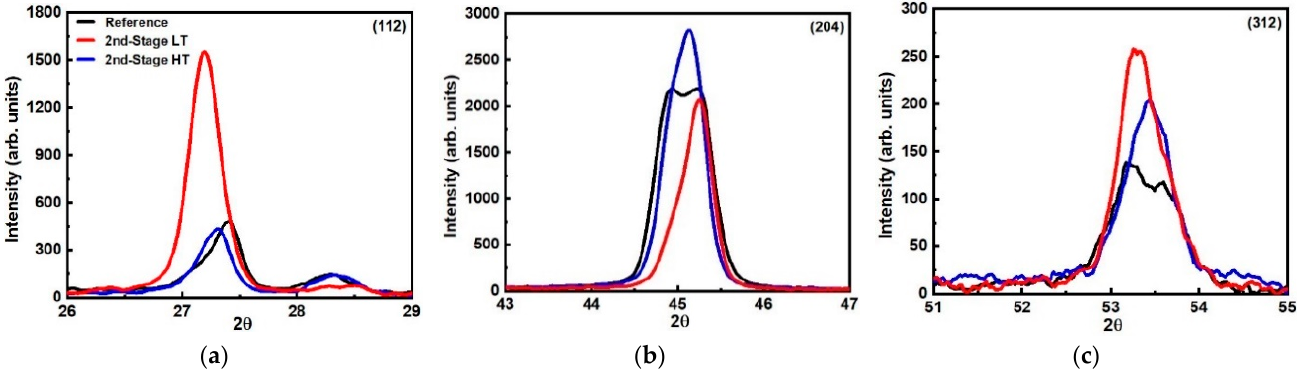
( a ) ( b ) ( c ) Figure 2. XRD plots (( a ): (112) peak, ( b ): (204) peak and ( c ): (312) peak) for the reference (black), second stage LT (red) and second stage HT (blue) CIGS samples recrystallized in a CuCl 2 environment. Table 2. XRD and XRF results for the reference, second stage LT and second stage HT CIGS samples.